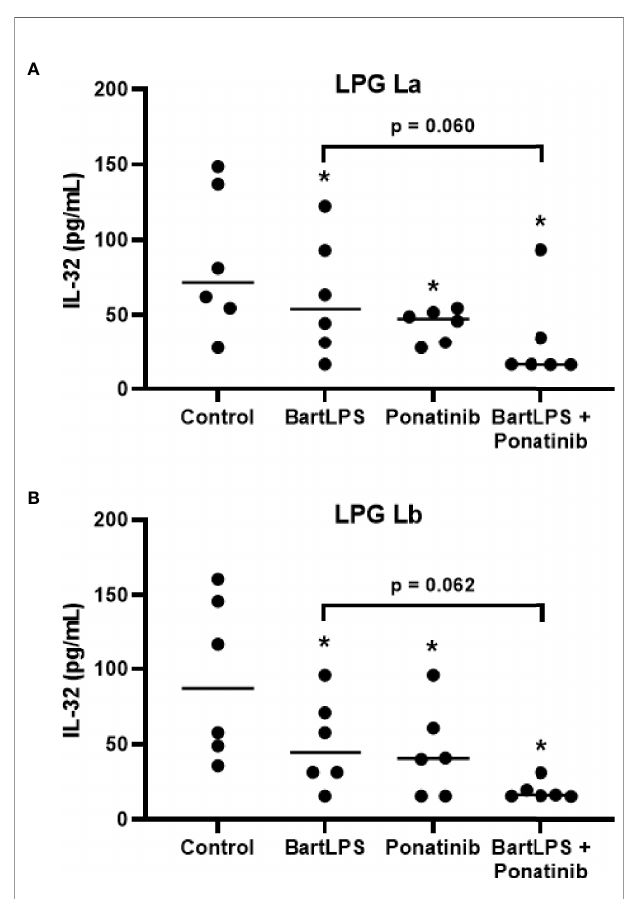
FIGURE 6 | Induction of IL-32 by lipophosphoglycans from Leishmania spp. is dependent on TLR4 and NOD2. PBMCs (5 x 10 5 cells/200 m L) were treated or not with LPS from Bartonella quintana (100 ng/mL) and/or Ponatinib (100 nM) for 1 h. Then, cells were incubated with LPG (10 m g/mL) from L. amazonensis (La; A ) or L. braziliensis (Lb; B ) for 24 h. Cell lysates were obtained for the IL-32 evaluation by ELISA. Data represent individual and median values (n = 6 donors, evaluated in three independent experiments). *p < 0.05 (vs. control) by Anova Kruskal-Wallis followed by Dunn ’ s post hoc